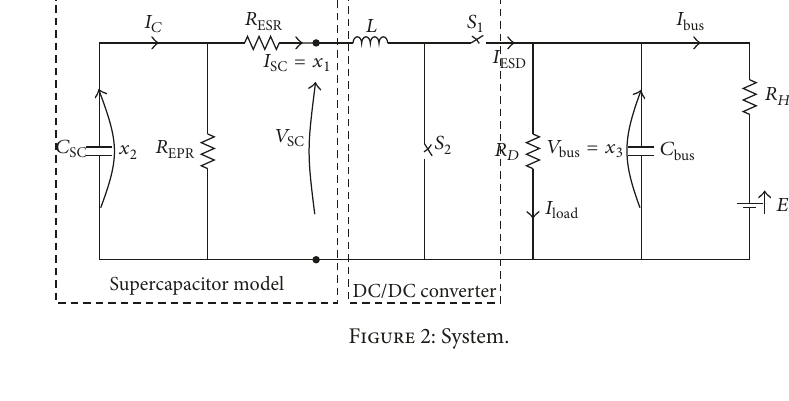
Figure 2: System.